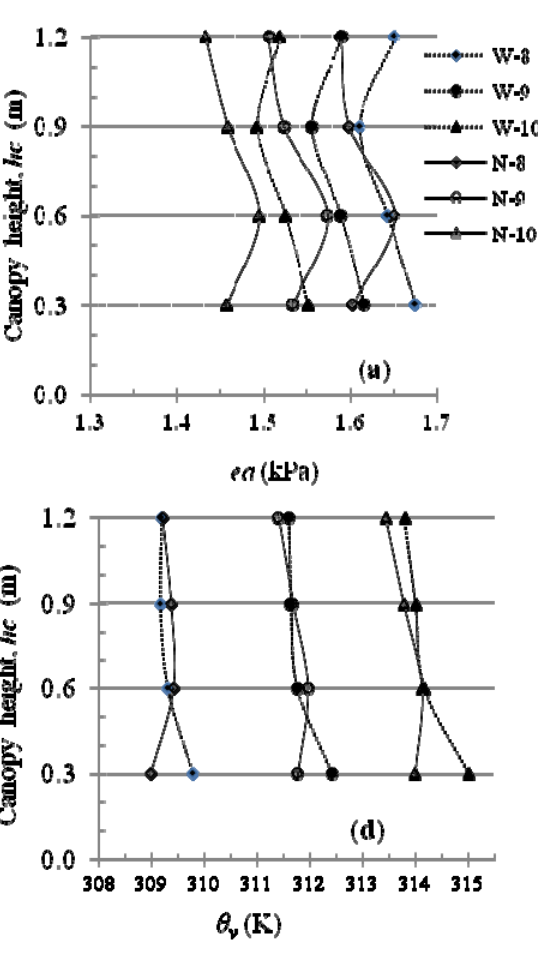
Figure 4. Hourly water vapor pressure ( a ) morning (8:00-10:00), ( b ) midday (11:00-13:00) and ( c ) afternoon (14:00-16:00)and virtual potential temperatues profiles for the ( d ) morning, ( e ) midday and ( f ) afternoon on 6 February 2009 (47 DAP). N-i and W-i represent time of day measurement was taken on narrow and wide strips,